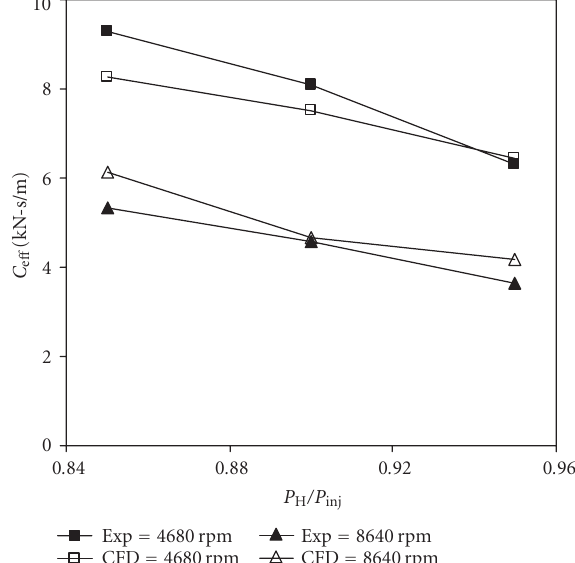
Figure 2: Validation of the perturbation model against measure- ments of (Soto and Childs [4]) e ff ective damping coe ffi cient at pres- sure ratio PR ( = P L /P H ) = 0 . 65 and ω = 4680rpm, 8640 rpm, re- spectively.